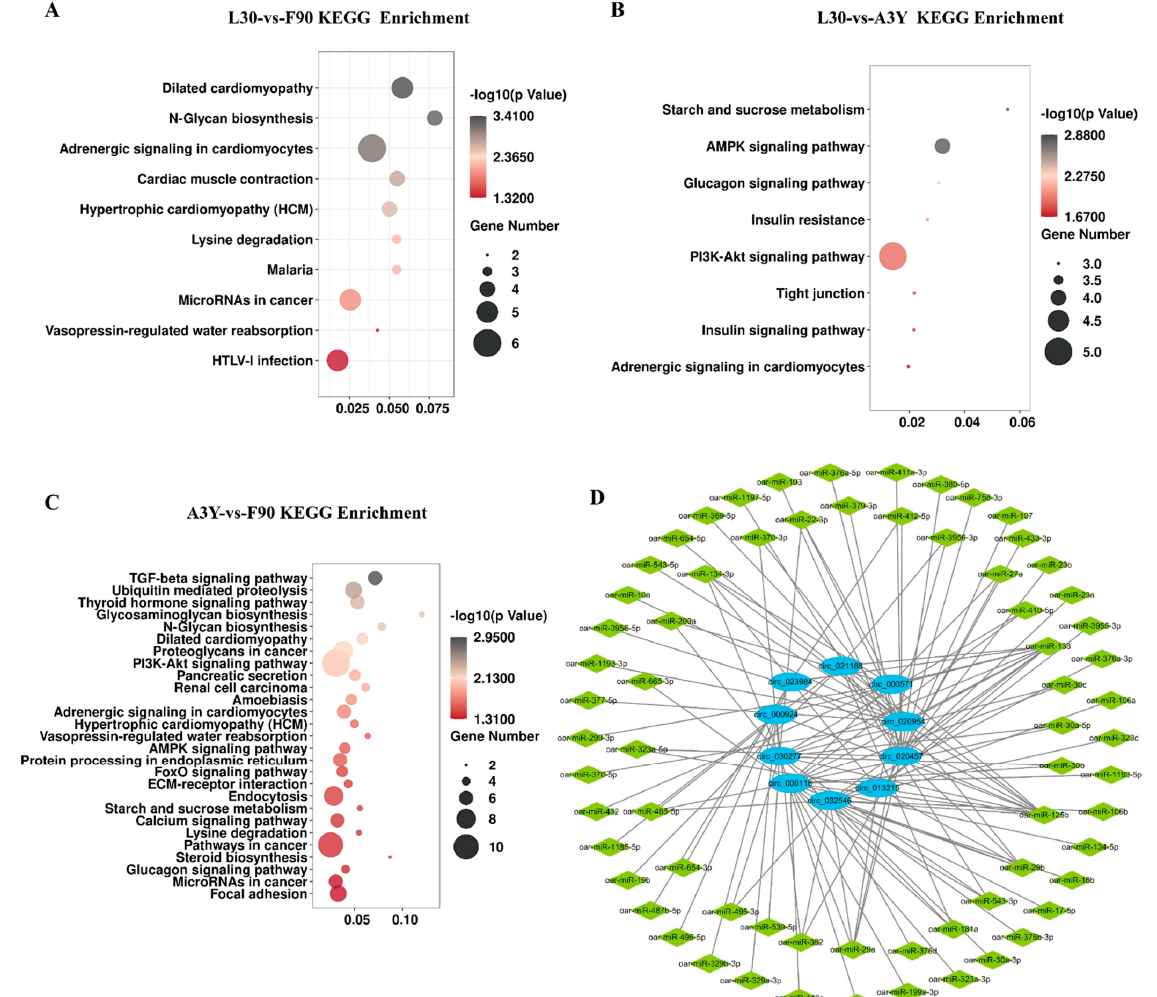
Figure 3. Kyoto Encyclopedia of Genes and Genomes pathways. ( A ) L30 vs F90, ( B ) A3Y vs F90, ( C ) L30 vs A3Y. ( D ) Regulatory networks of circRNAs–miRNAs.